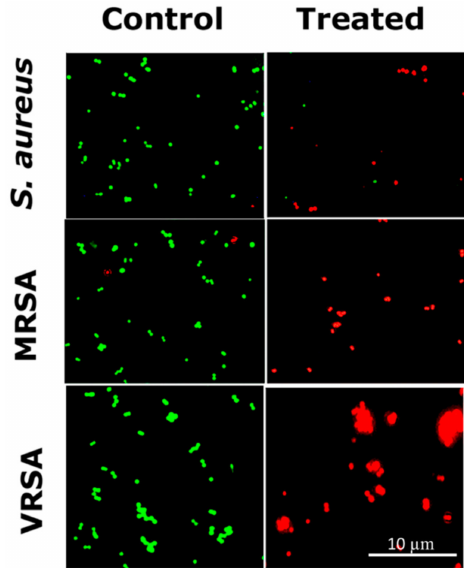
Figure 8. LIVE / DEAD cell imaging for RU-S4 treatment against S. aureus (NCTC 8511), MRSA (ST239: SCCmecIIIA), and VRSA (CCM 1767). Green cells define living cells whether red cells stand for dead cells. Scale bar is 10 µ